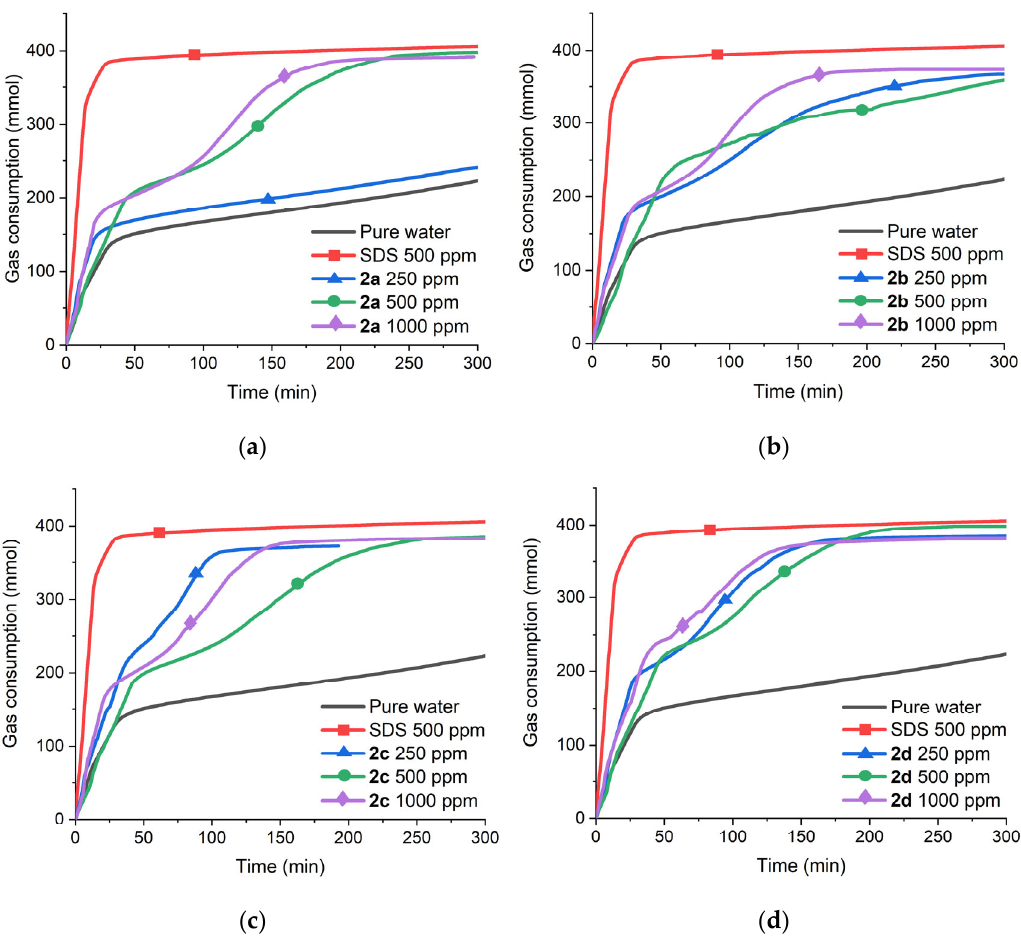
Figure 3. Gas consumption for samples: ( a ) 2a ; ( b ) 2b ; ( c ) 2c ; and ( d ) 2d in comparison with pure water and SDS. Table 1. Hydrate conversion, maximum mole consumption, and kinetic constants of methane hydrate formation for pure water and 2a – d solutions at different concentrations.